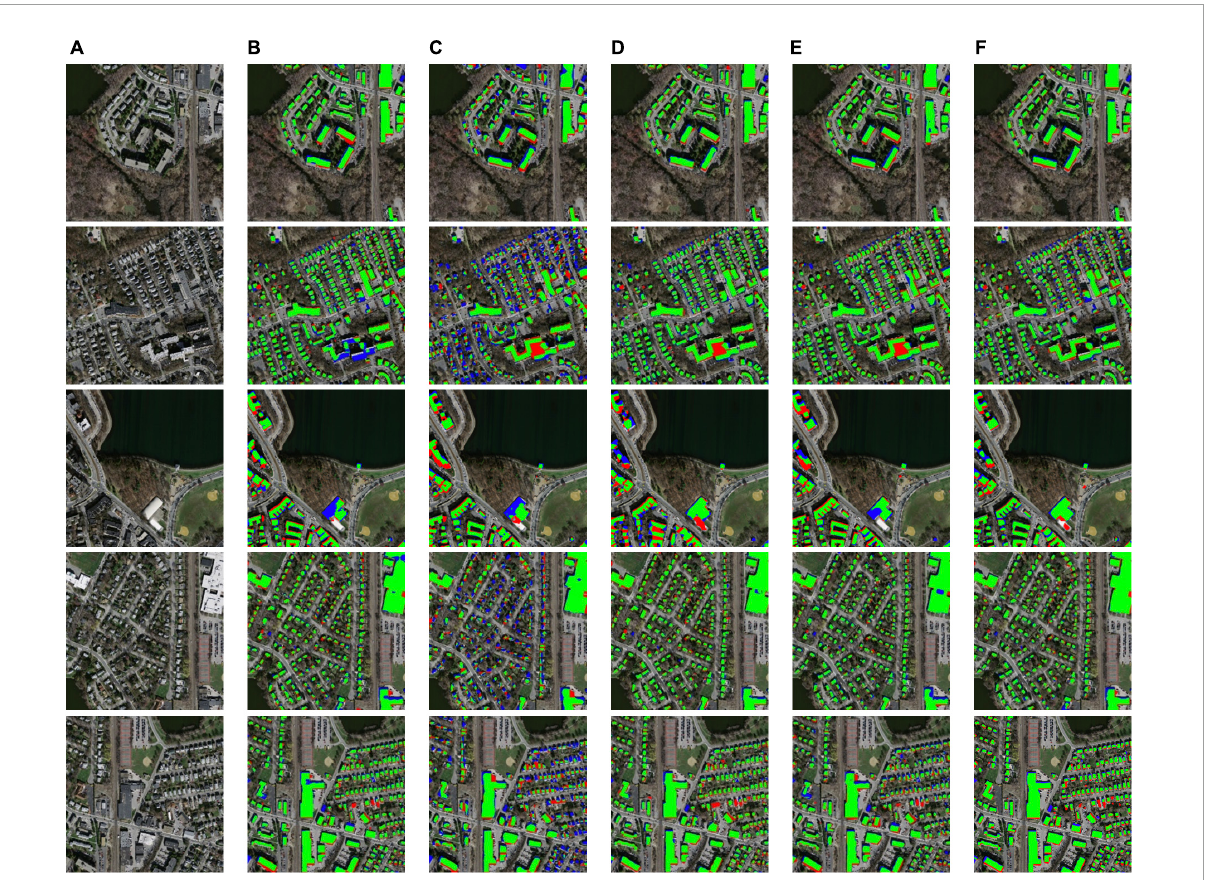
FIGURE10 Building extraction results: (A) original remote sensing image; (B) prediction of U-Net; (C) prediction of DeepLabv3+; (D) prediction of PSPNet; (E) prediction of DANet; (F) prediction of AttsegGAN (ours). Green: true positive (tp) pixels; transparent: true negative (tn) pixels; red: false positive (fp) pixels; blue: false negative (fn)